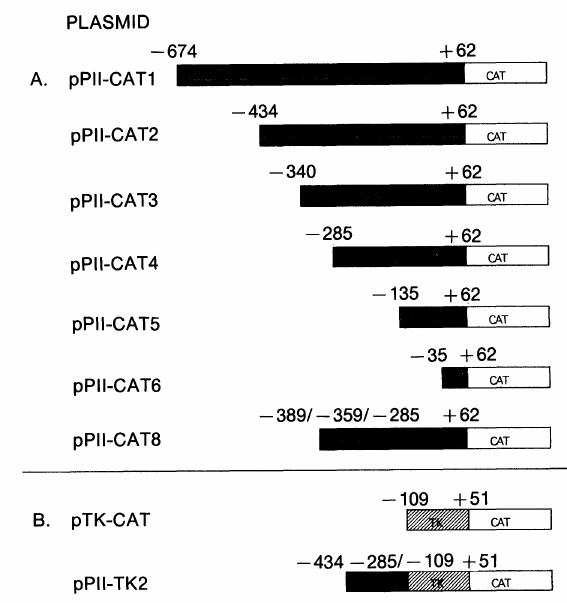
FIG. 1. Schematic diagram of pPII-CAT and pPII-TK constructs. (A) Acetyl CoA carboxylase promoter II fragments were inserted upstream of the CAT gene in pUC-CAT3. The numbers in the figures refer to the nucleotide positions in the promoter; the value +1 was assigned to the transcription initiation site. (B) The promoter fragment ranging from 434 to 285 was inserted in front of pTK-CAT to create pPI I-TK2.